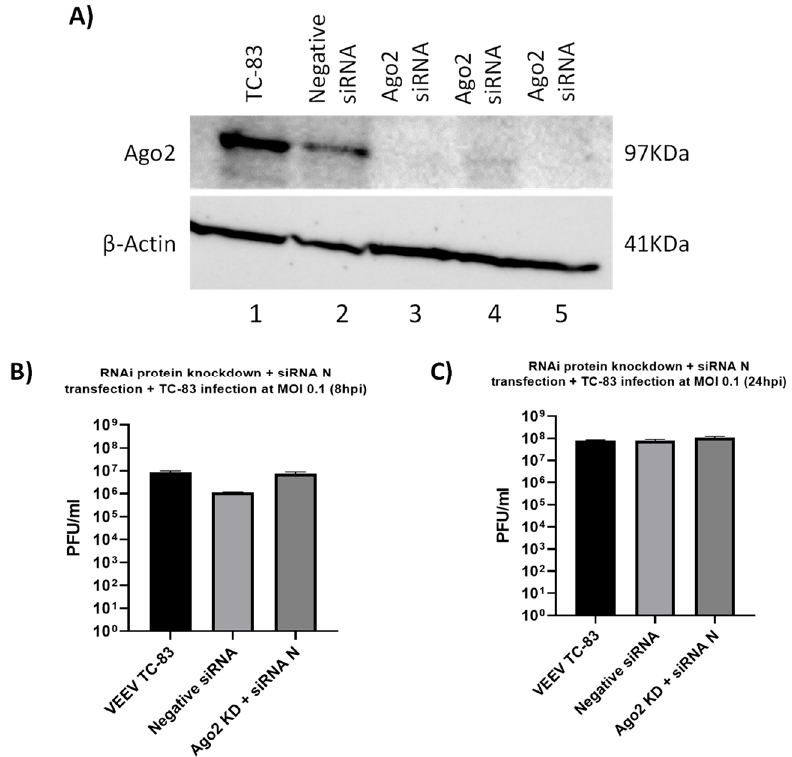
Figure 6. Mechanistic assessment of antiviral activity of vsiRNA. ( A – C ) 293T cells were transfected with 20 nM anti-human Ago2 siRNA for 72 h. Ago2 knockdown cells were then transfected with siRNA N for 24 h prior to infection with VEEV TC-83 at an MOI of 0.1. ( A ) Cell lysates were analyzed by Western blot and probed for Ago2 to determine knockdown and actin as a loading control. ( B , C ) Culture supernatants were collected at 8 and 24 hpi and viral titer was determined via plaque assay. Graphs are representative of one independent experiment ( n = 3).